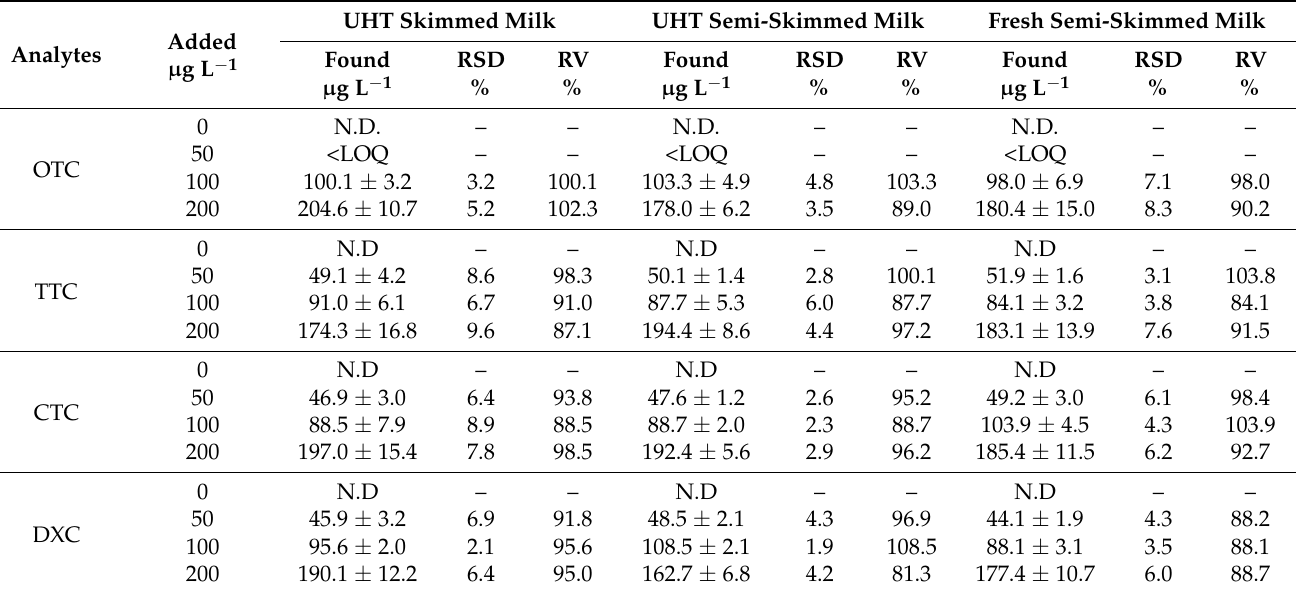
Table 5. Recovery values of the proposed HPLC-POT for the determination of TCs in spiked milk samples (n = 3 for each concentration).